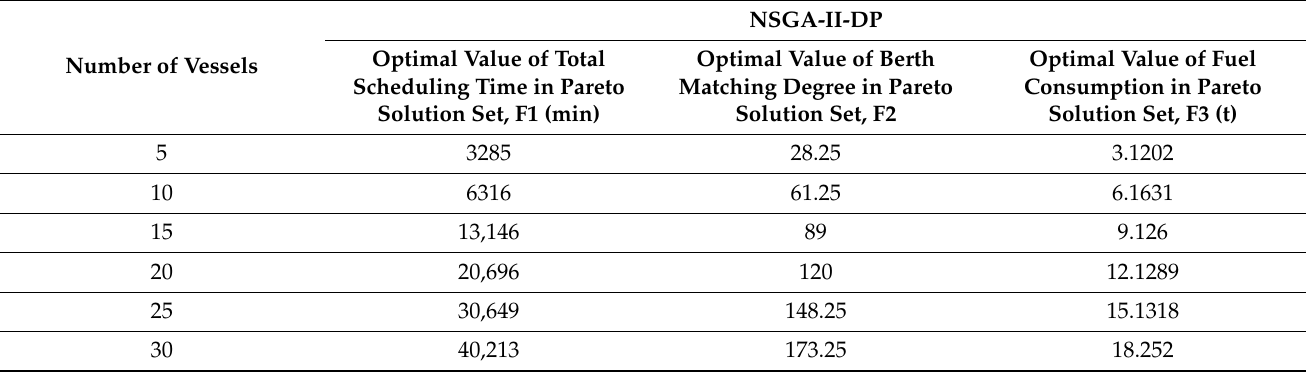
Table 9. Results of applying the NSGA-II-DP algorithm to cases with different numbers of